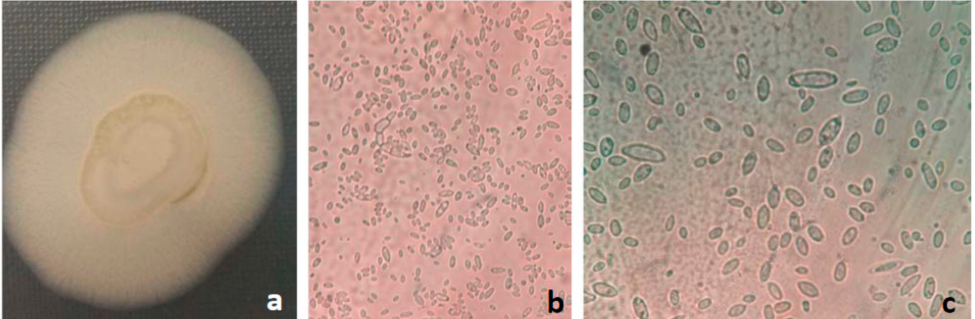
Figure 1. Aureobasidium pullulans ( a ) colony on Sabouraud Dextrose Agar ( b ) microscopic view of yeast-like cells with characteristic pseudomycelium, ( c ) characteristic microscopic view of yeast-like cells of various shapes and